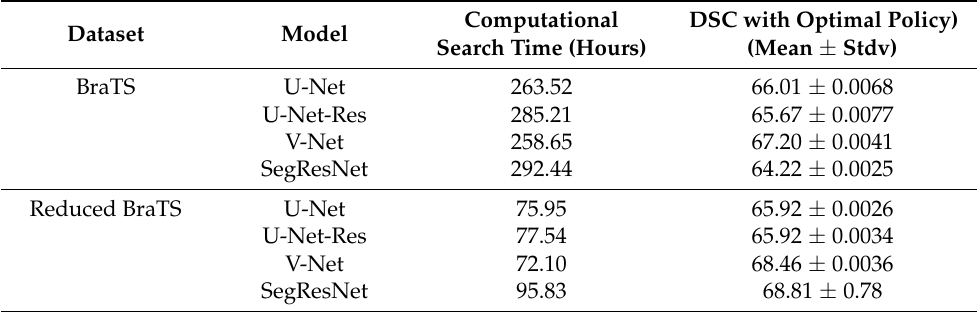
Table 6. Evaluation on performance with BraTS and reduced BraTS using our medical DA search. (IoU version of this table is found in Appendix